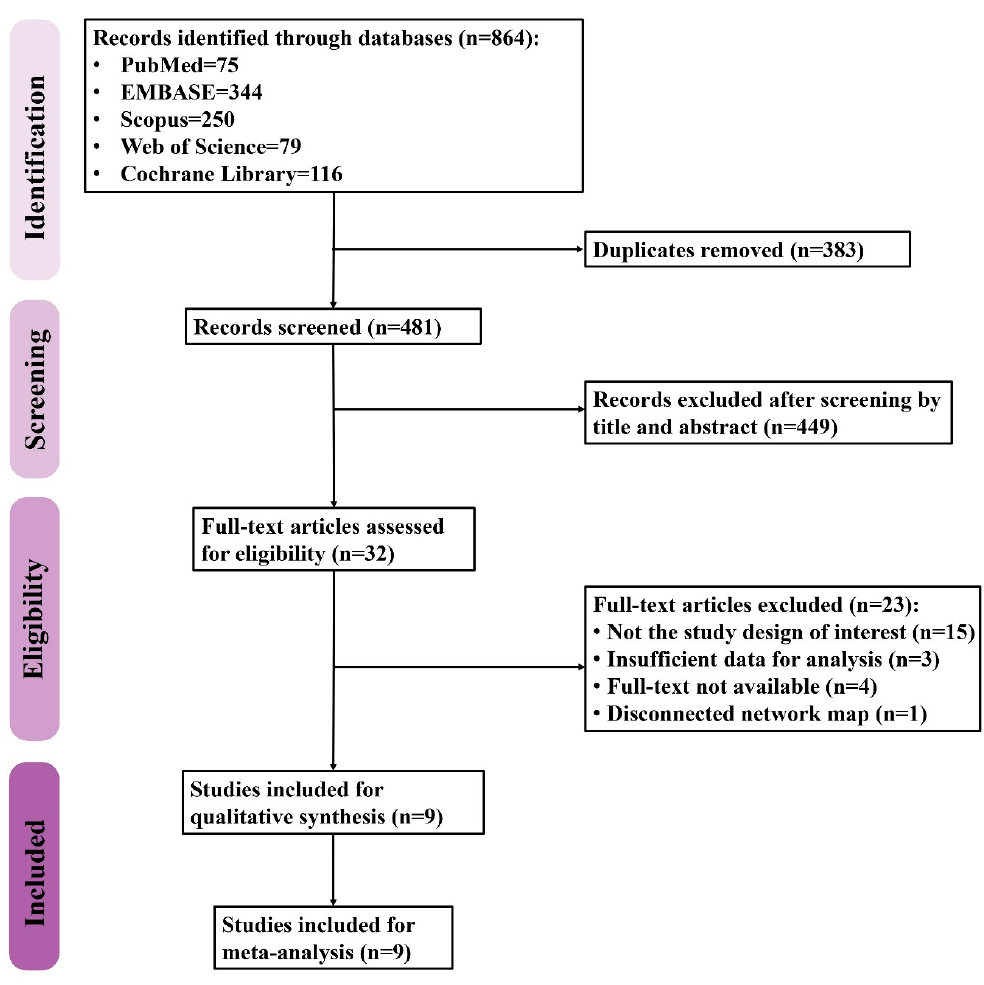
Figure 1. The flow diagram of study selection.